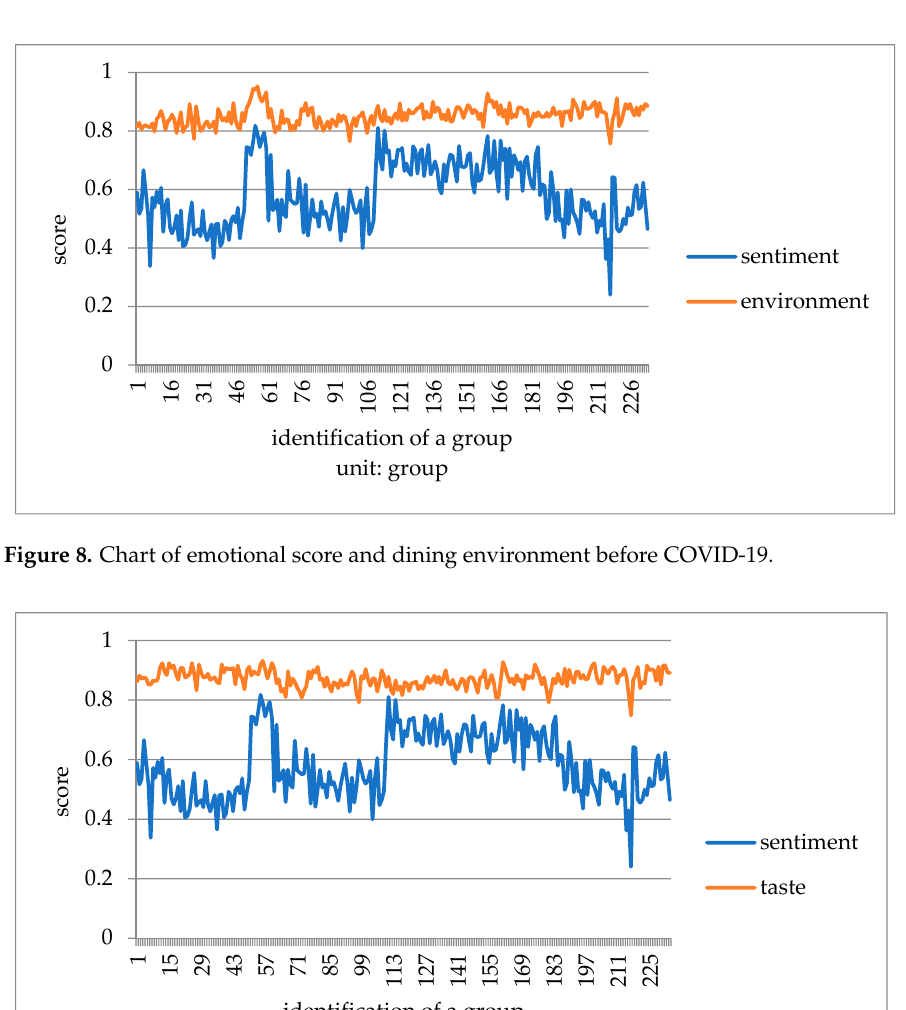
Figure 7. Chart of emotional score and dish taste before COVID-19.